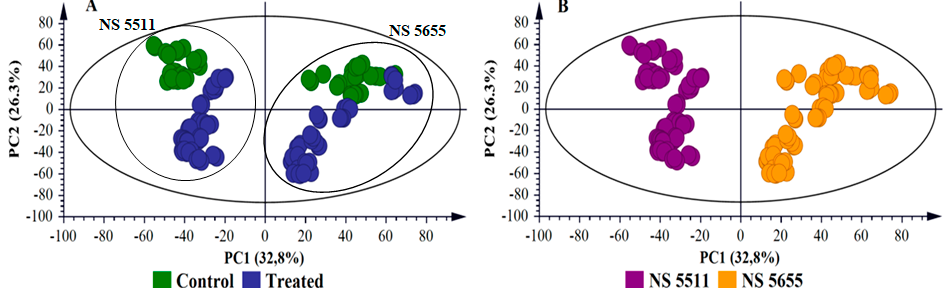
Figure 2. Principal component analyses of the ESI negative data for sorghum NS 5511 (BT) and NS 5655 (ST) extracts. (A) and (B) are 15-component models, explaining 86.0% variations in Pareto-scaled data, X, and the amount of predicted variation by the model, according to cross-validation, is 79.6%. (A) and (B) represent the same scores plot, with (A) coloured according to condition (control, green vs. infection treatment, blue) and (B) coloured according to cultivar. This two-dimensional scores space, spanned by the first two PCs, reveals infection-related sample clustering ( A , control vs. treated) and cultivar-related clustering ( B , NS5511 vs. NS 5655).